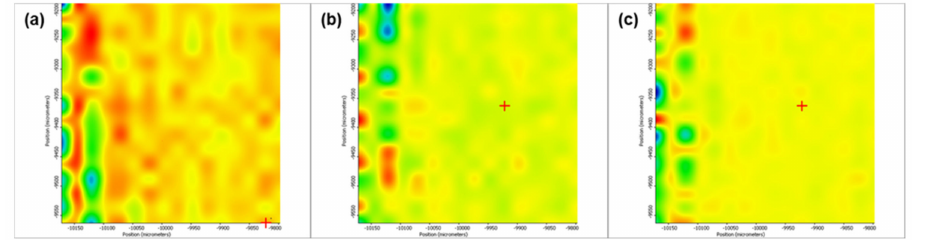
Figure 11. Second derivate IR mappings of Fe 3 O 4 @ β -CD/PTX thin films deposited at F = 400 mJ/cm 2 : surface intensity distribution of ( a ) 2930 cm − 1 , ( b ) 1029 cm − 1 and ( c ) 1739 cm − 1 .